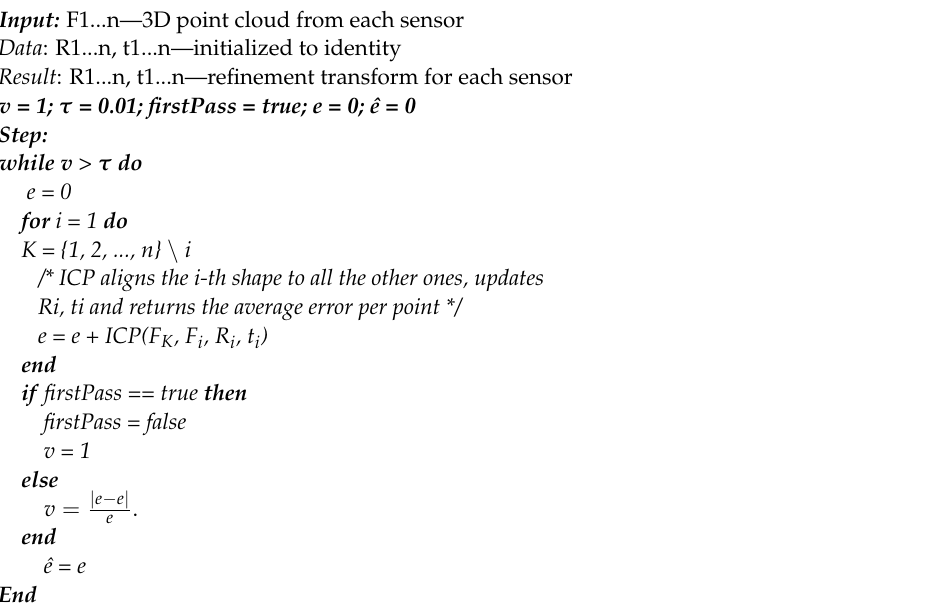
Algorithm 1: Iterative Closest Point